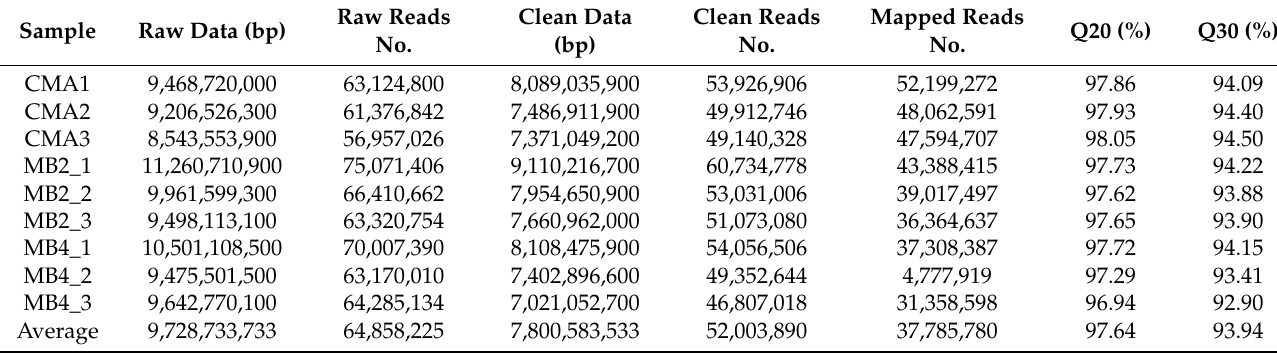
Table 1. Summary of transcriptome sequencing data of M. aeruginosa under B. laterosporus